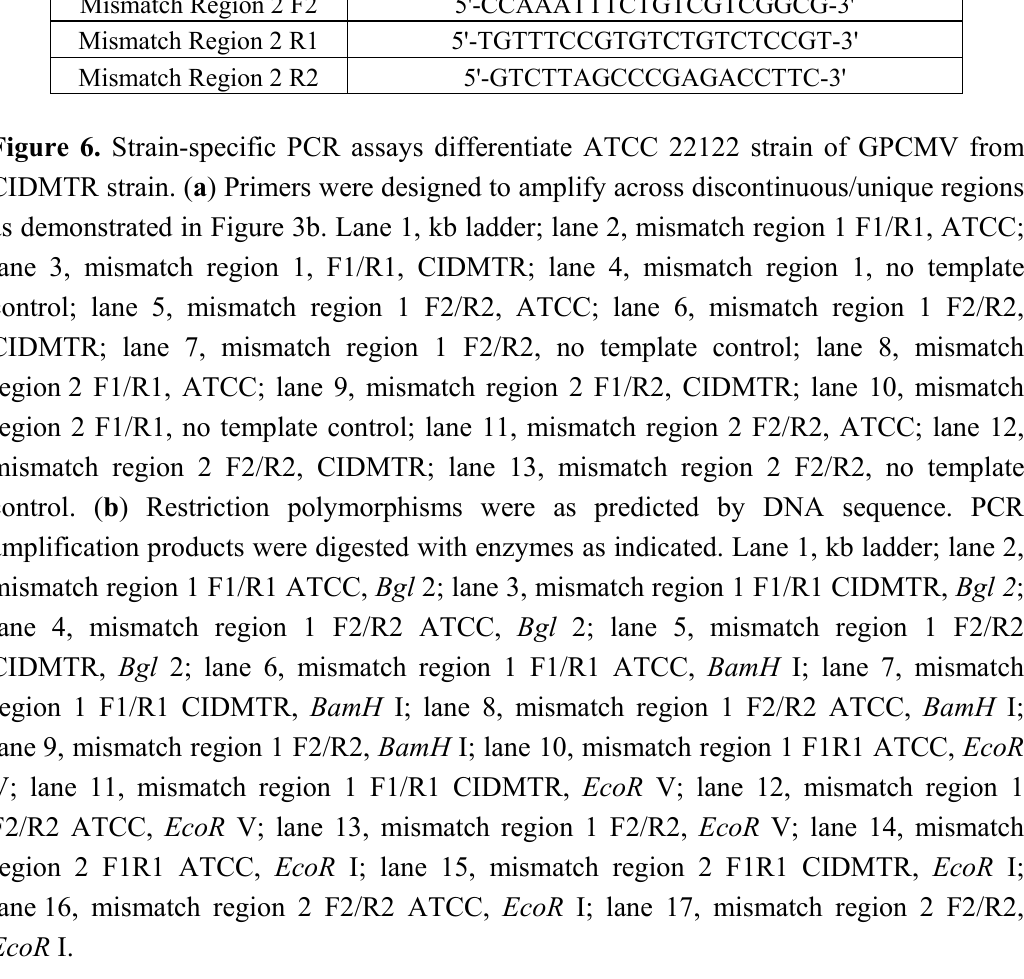
Table 2. Primer Sequences.